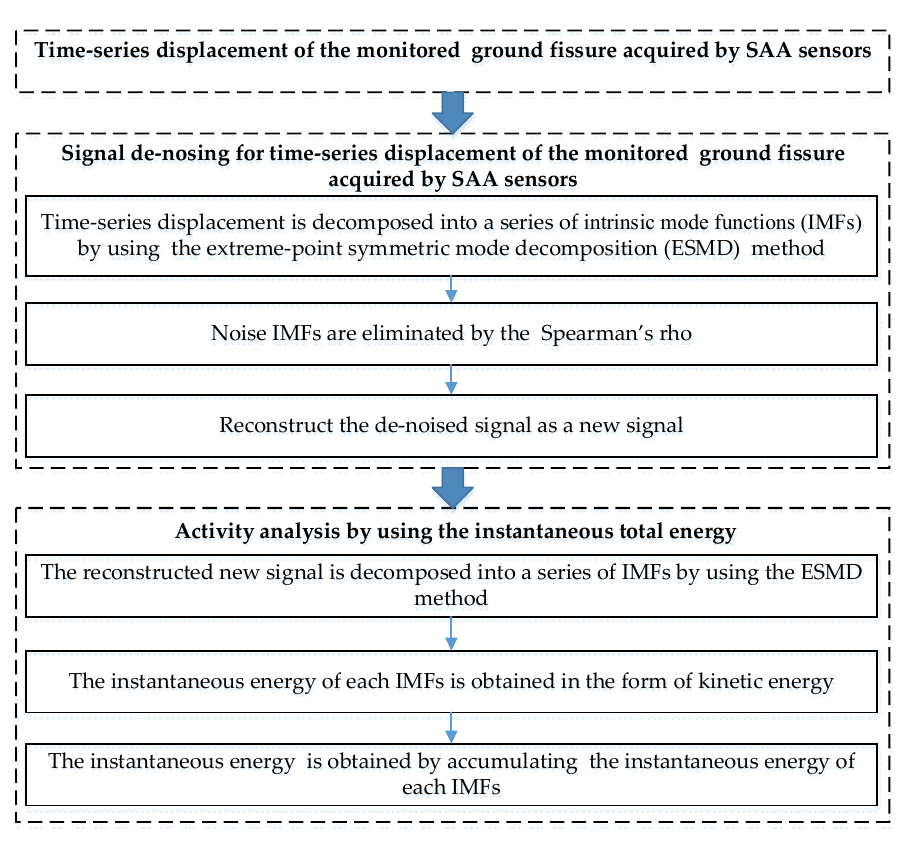
Figure 5. Workflow of the activity analysis using the instantaneous total energy.